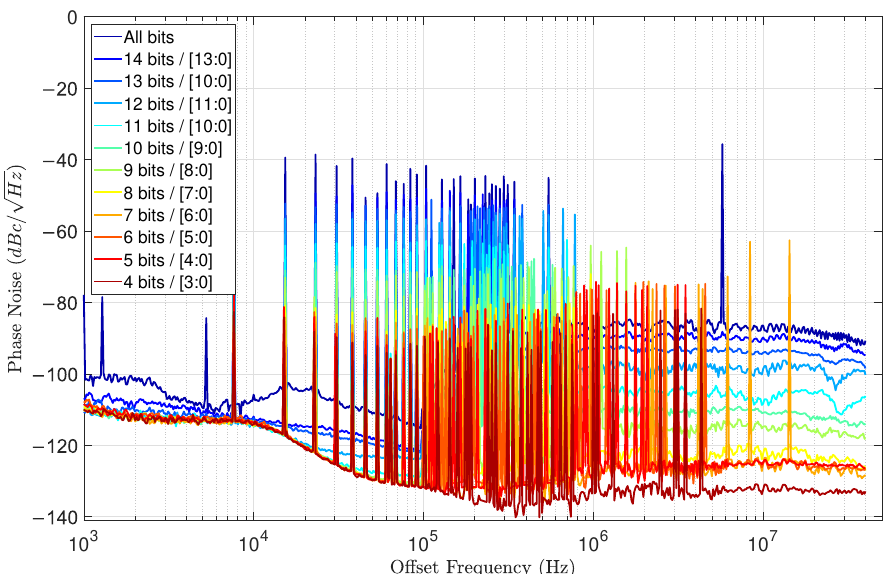
Figure 5. The PN spectra of the 15-bit maximum-length LFSR modulated test signals generated using the AD9910 DDS.